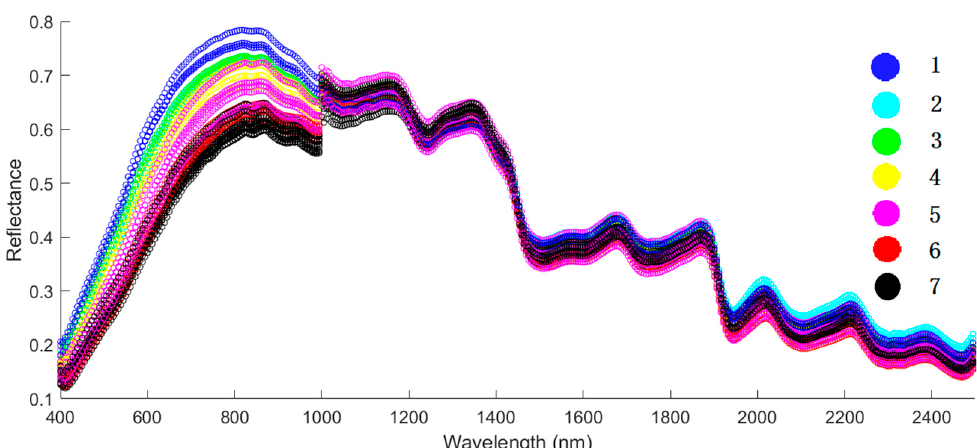
Figure 2. The spectral reflectance of ginseng samples. Ages from 1 to 7 years are marked as different colors. There are 35 samples in total. For the different illuminating angles between VNIR and SWIR cameras, the curve shows a fault on 1000 nm, which can be neglected for fixed viewing and illuminating conditions for every sample.